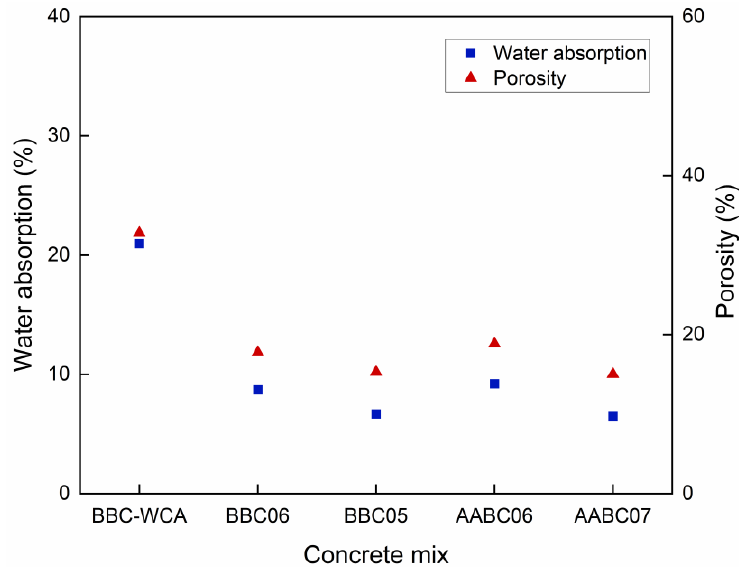
Figure 13. Water absorption and porosity for each concrete mix.